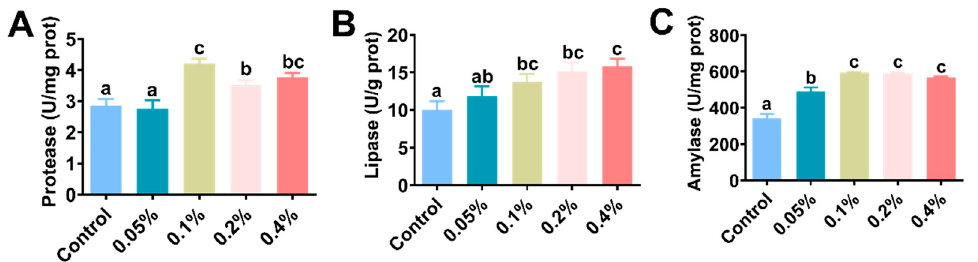
Figure 1. Relationships of ( A ) specific growth rate and ( B ) weight gain with dietary β -glucan levels based on second − order polynomial regression analysis of Juvenile L. vannamei , where Xopt represents the dietary β -glucan level ( n = 4).